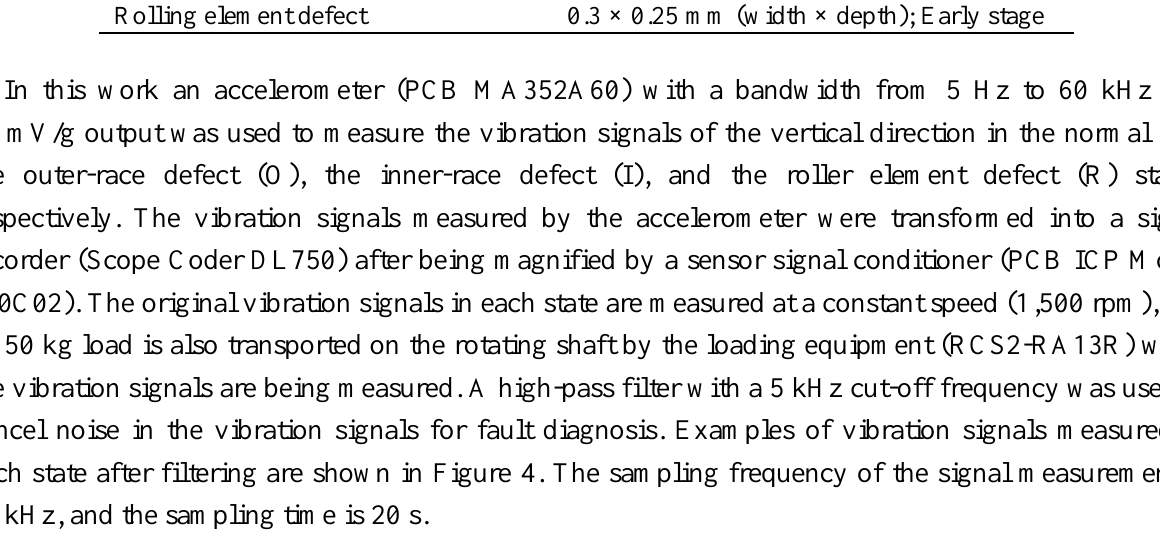
Figure 4. Vibration signals of bearings after